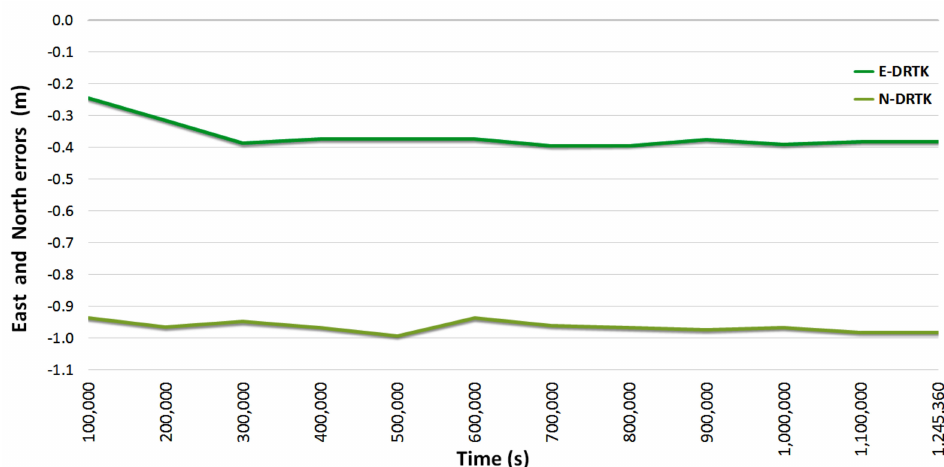
Figure A2. The relationship between the time and the East and North errors of Trimble Geo XT device. East and North errors are the differences between the control point and coordinate means. Table A3. Samsung Galaxy S3 device period of recorded data, and coordinate means for E and